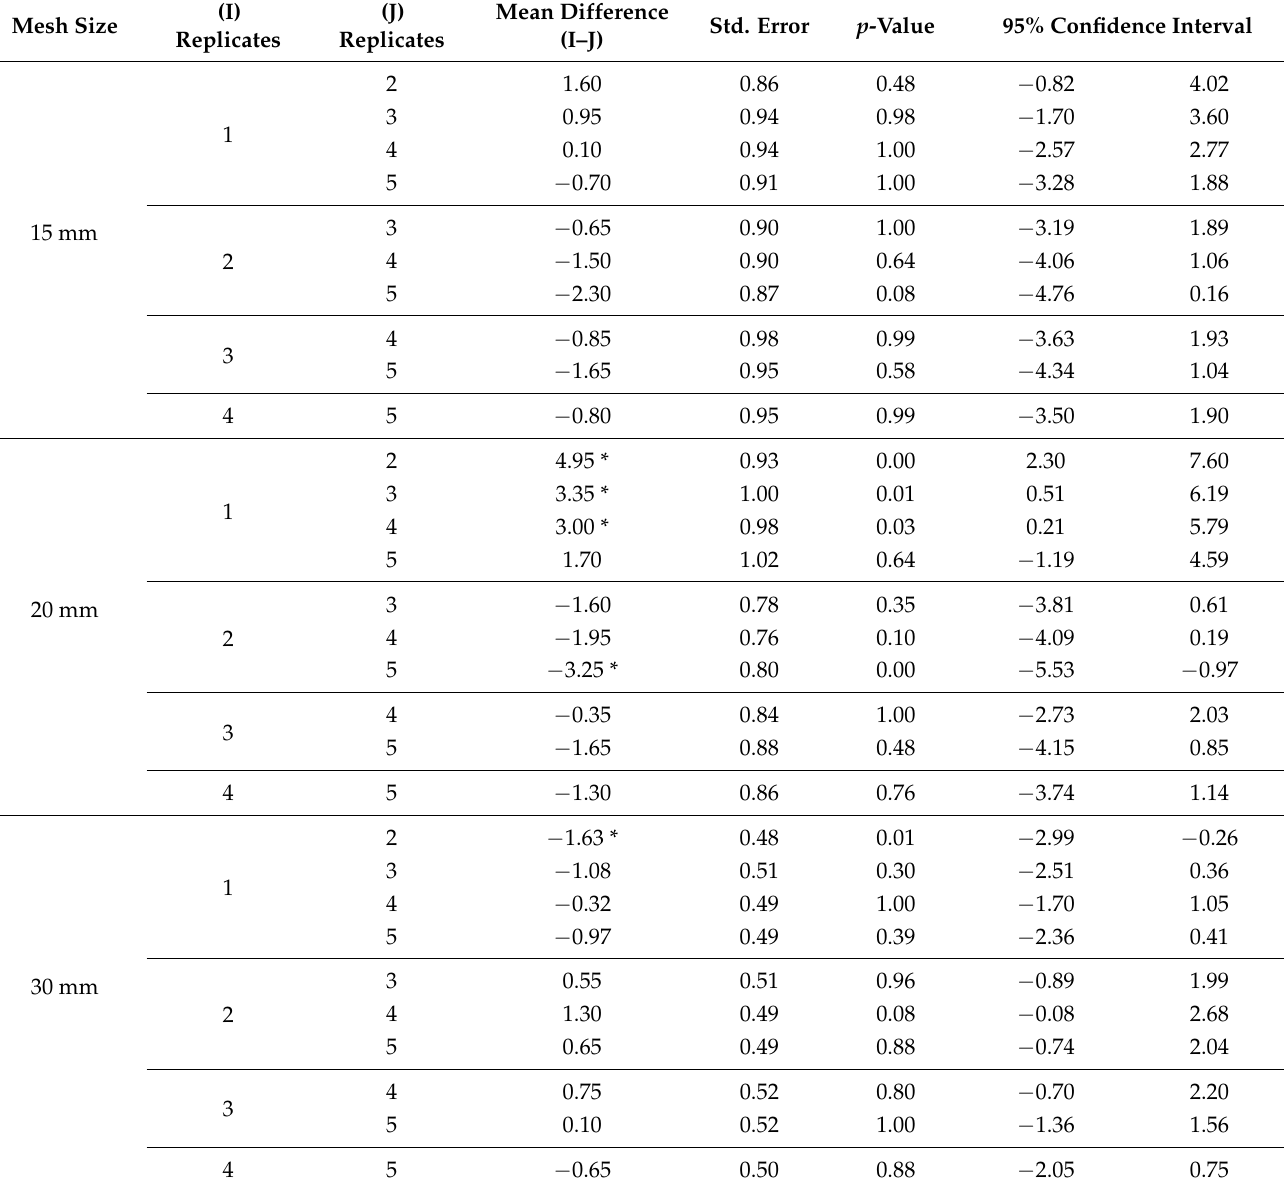
Table 1. SPSS multiple comparison (least significant difference (LSD)) results of a one-way ANOVA between replicates of a given mesh size (i.e., 15 mm, 20 mm and 30 mm). The significance level threshold ( p -value) was set to 0.05. The symbol * indicates significant inter-replicate differences among length compositions of krill. Mesh